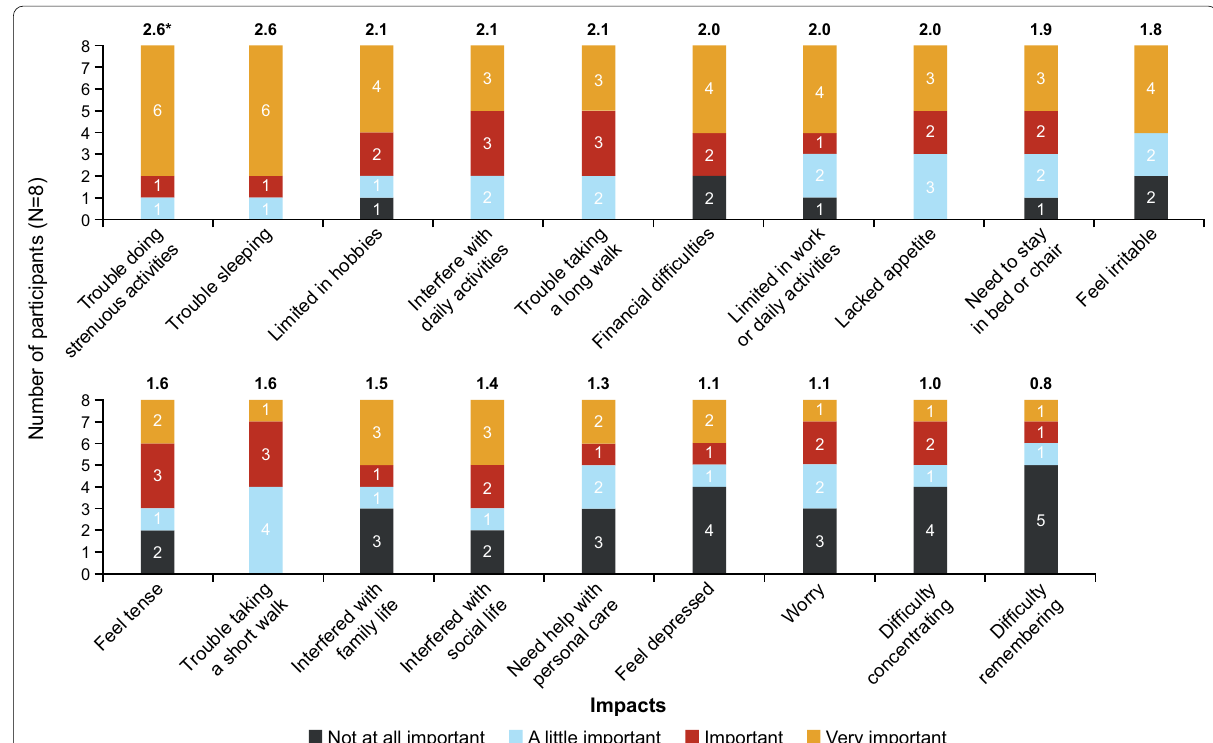
Fig. 6 Importance Rating of Impact Concepts. *Values at the top of each bar denote mean importance rating for that symptom generated from a scoring system of 0 not at all important; 1 a little important; 2 important; 3 very important; therefore, the higher the score, the greater the = = = = importance of the